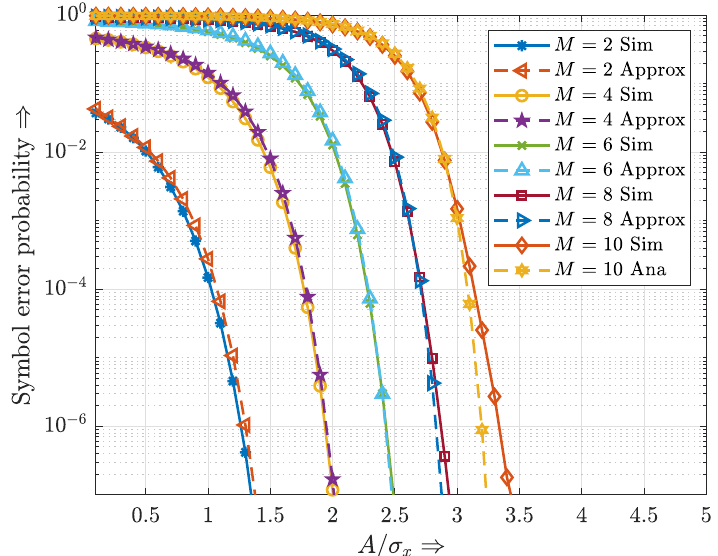
Figure 13. Simulated and calculated symbol error probability for a 2 M -QAM OFDM-transmission that suffers from clipping at level the A based on the approximated power spectral